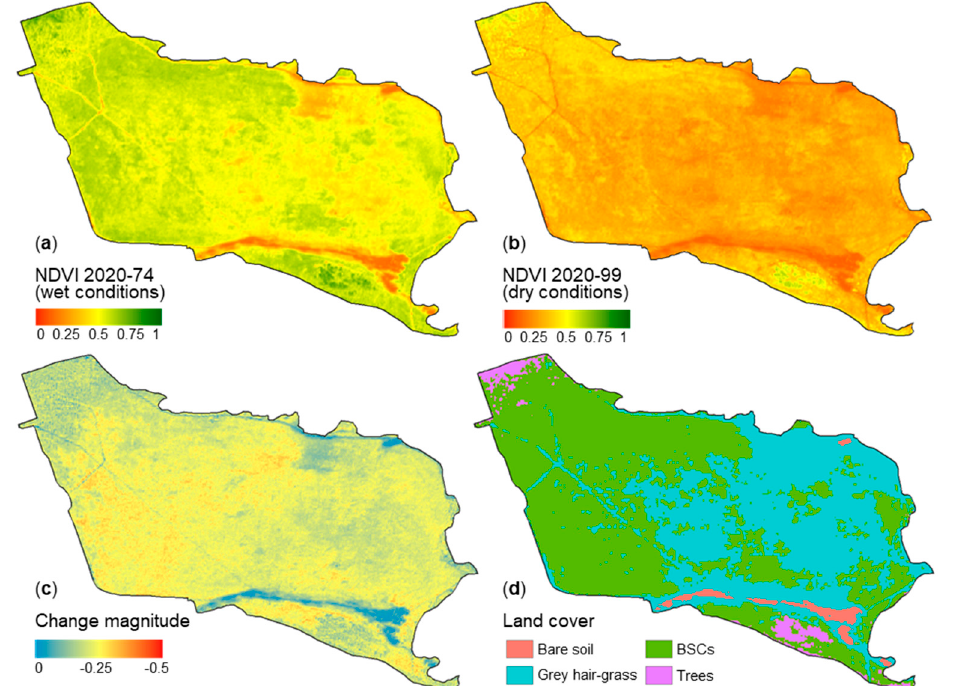
Figure 8. Spatial patterns of Sentinel-2-based NDVI values in the study area during 2020 where day-of-year (DOY) 74 represents wet conditions ( a ) and DOY 99 represents dry conditions ( b ), together with the change magnitude between these two observations ( c ), and the Random Forest-based land cover classification for orientation ( d ). The spatial resolution of the maps is 10 m.